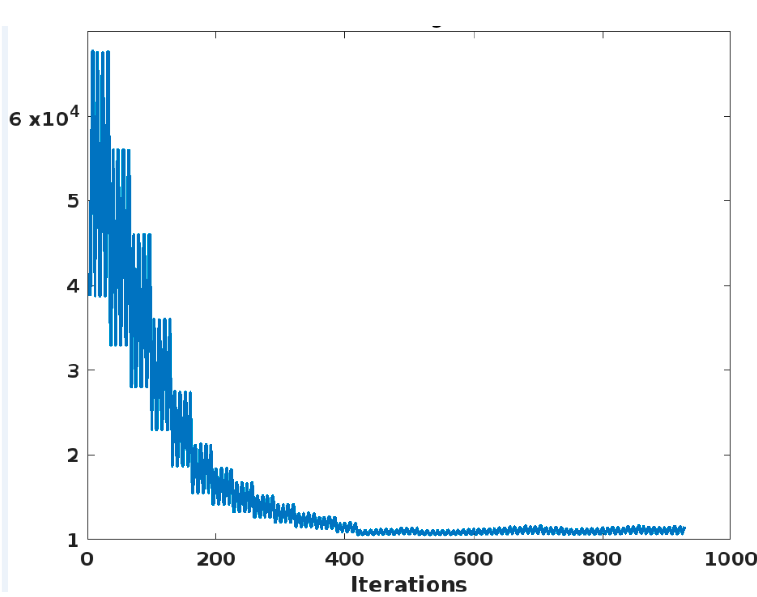
Figure 5. Fitness plot of ZESO.